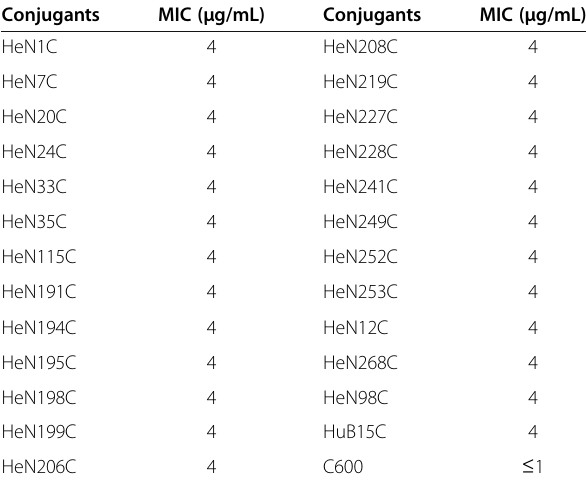
Table 3 Minimum inhibitory concentration (MIC) analysis of colistin for transconjugants and the recipient E. coli C600